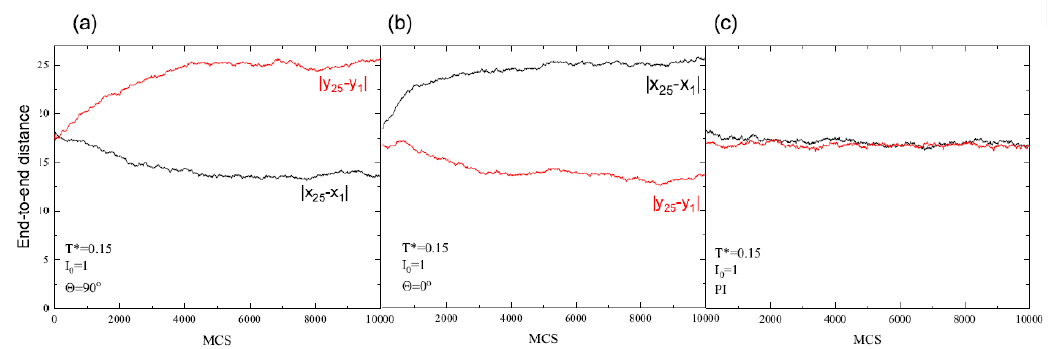
Figure 3. MC dynamics of averaged end-to-end distances ∆ x (red) and ∆ y (black): for FPM with Θ = 90 ◦ ( a ) and Θ = 0 ◦ ( b ); and for PI model ( c ). I approximately 1.